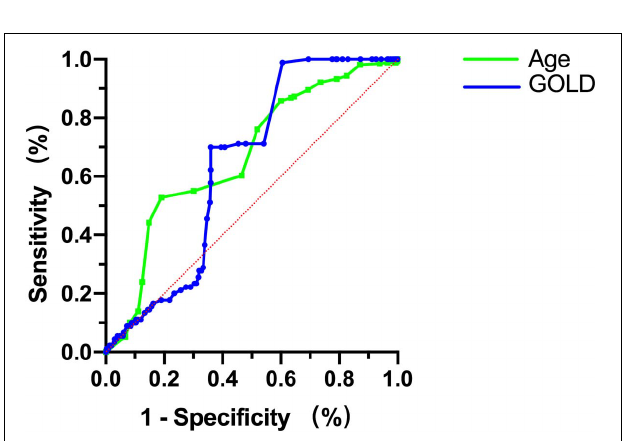
FIGURE 5 | Receiver operating characteristic curves for age and GOLD in the diagnosis of short-term